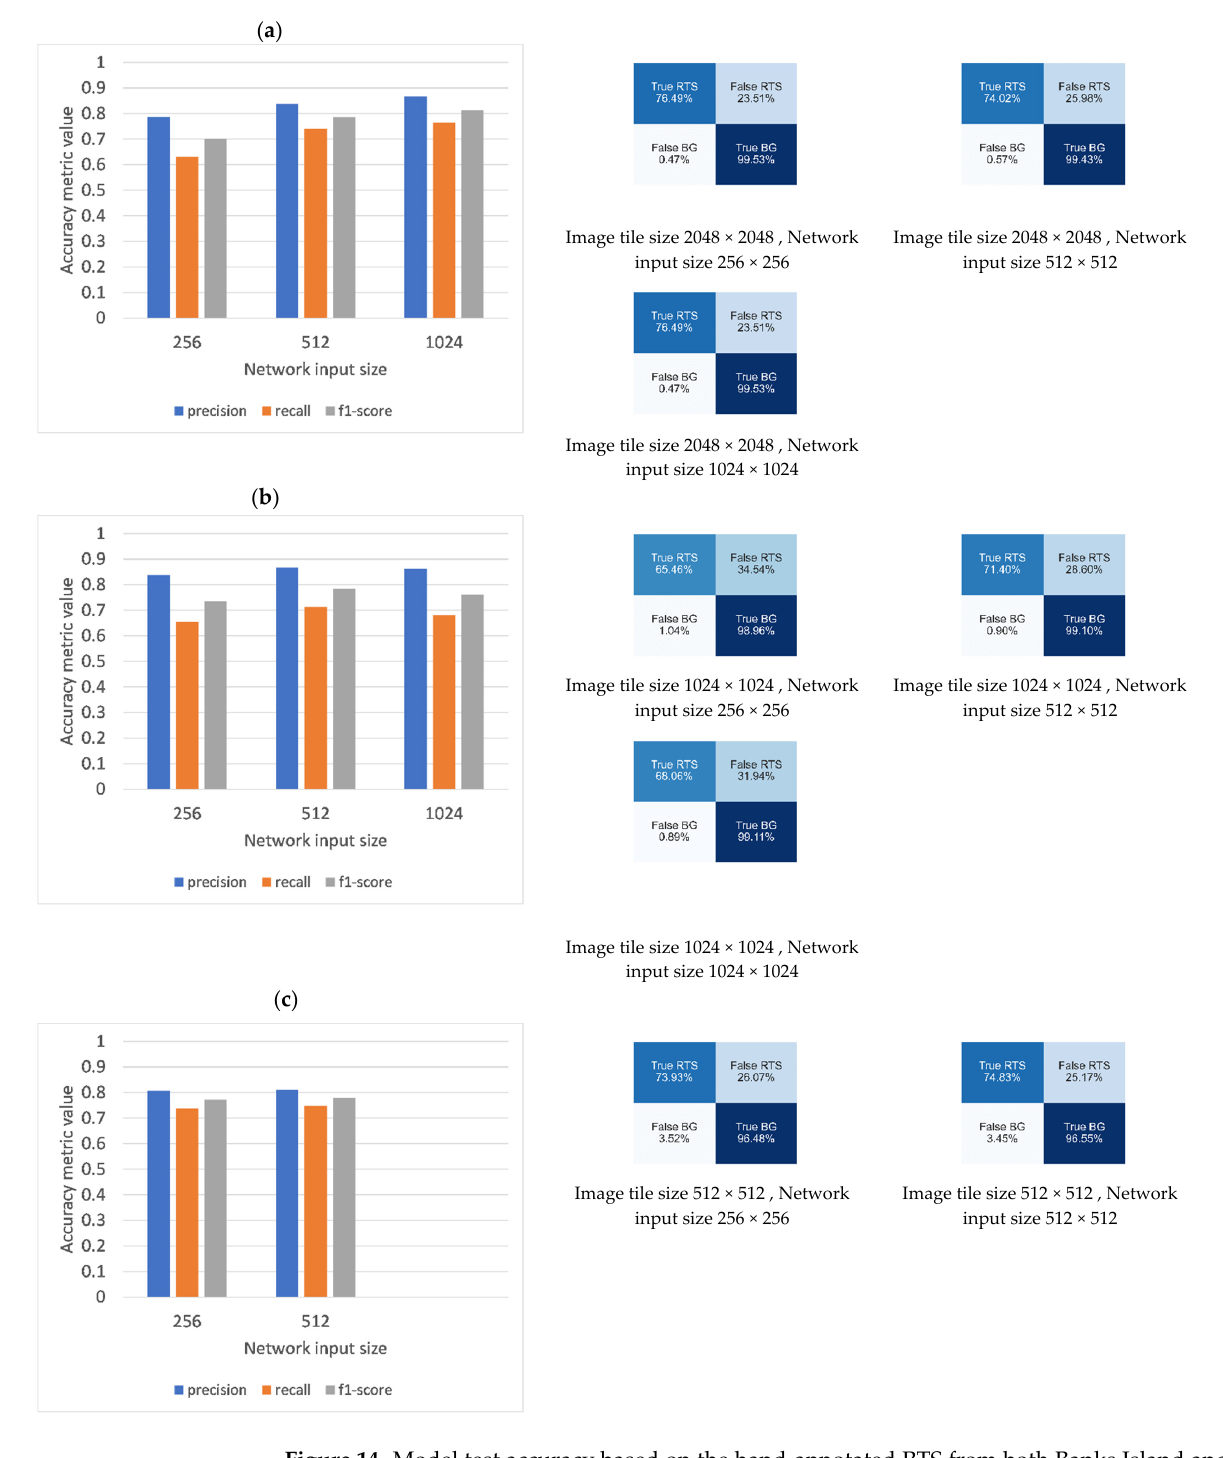
Figure 14. Model test accuracy based on the hand-annotated RTS from both Banks Island and the Eureka Sound Lowlands (combined RTS samples). ( a ) Image tile size of 2048 × 2048 resized to network input sizes of 256 × 256, 512 × 512, and 1024 × 1024. ( b ) Image tile size of 1024 × 1024 resized to network input sizes of 256 × 256, 512 × 512, and without resizing as 1024 × 1024. ( c ) Image tile size of 512 × 512 resized to network input size of 256 × 256 and without resizing as 512 × 512. Bar charts depict accuracy measures of Precision, recall, and F1 score. Corresponding confusion matrix for each of the scenarios shown on the